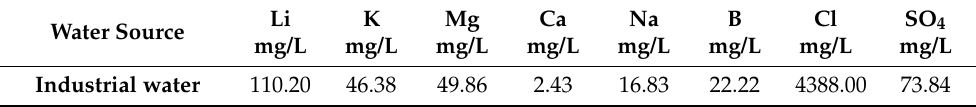
Table 3. Elements present in the industrial water